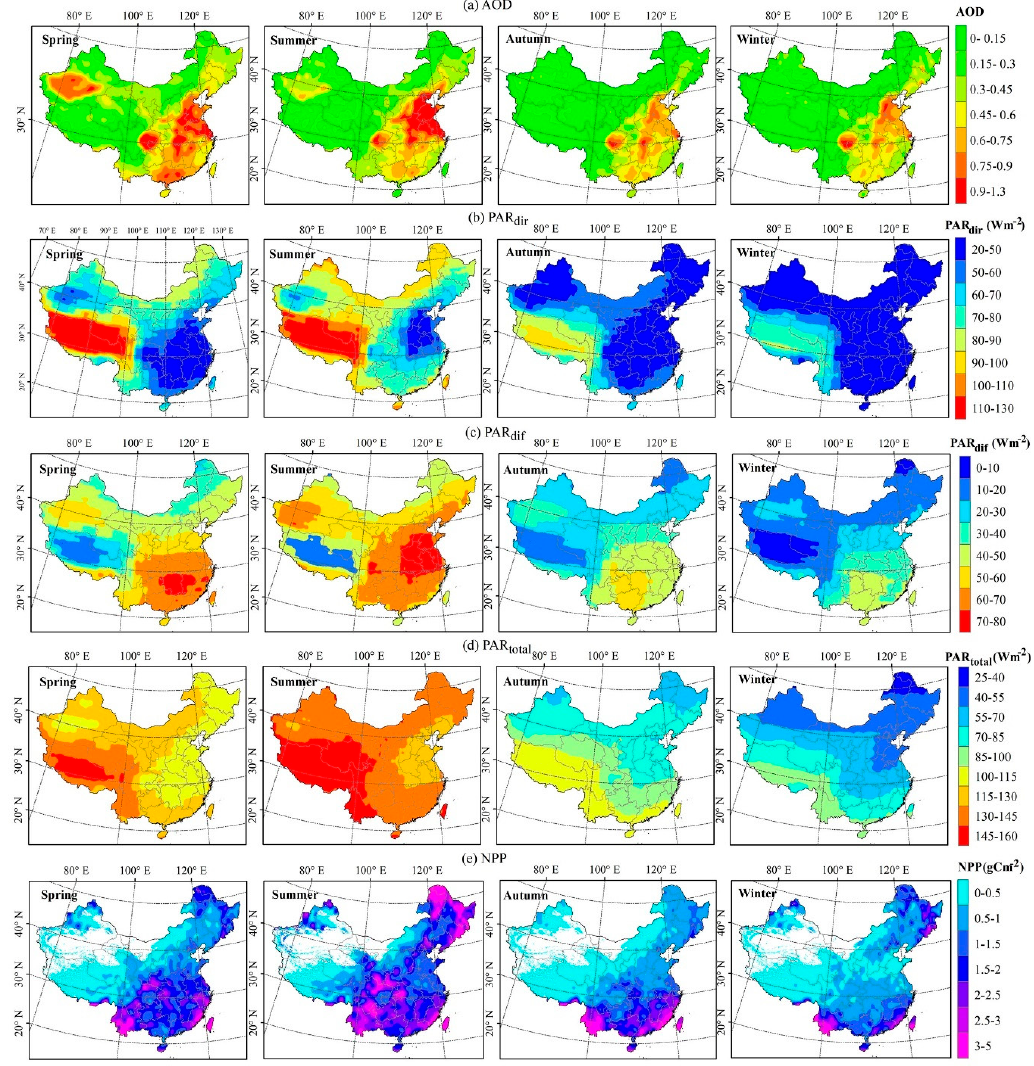
Figure 4. Seasonal variations of ( a ) AOD, ( b ) PAR dir , ( c ) PAR dif , ( d ) PAR total and ( e ) NPP in spring winter (December, January, February) during 2001–2017.